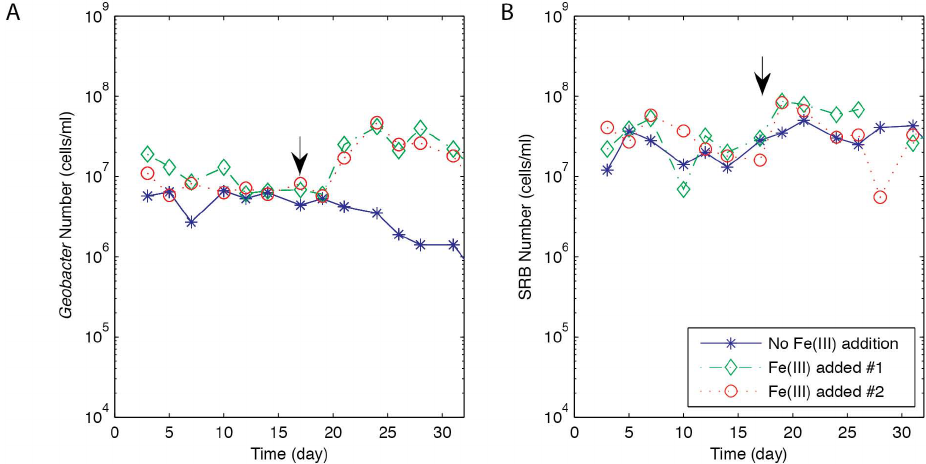
Fig. 5. Observed Impact of Fe(III) oxide additions on the number of Geobacter (A) and SRB (B) . The green (diamond style) and red (circle style) lines indicates the data from two bottles in which Fe(III) was added. The blue (star style) line indicates the data from the bottle in which no Fe(III) was added. The black arrows indicates the time Fe(III) was added to both bottles #1 and